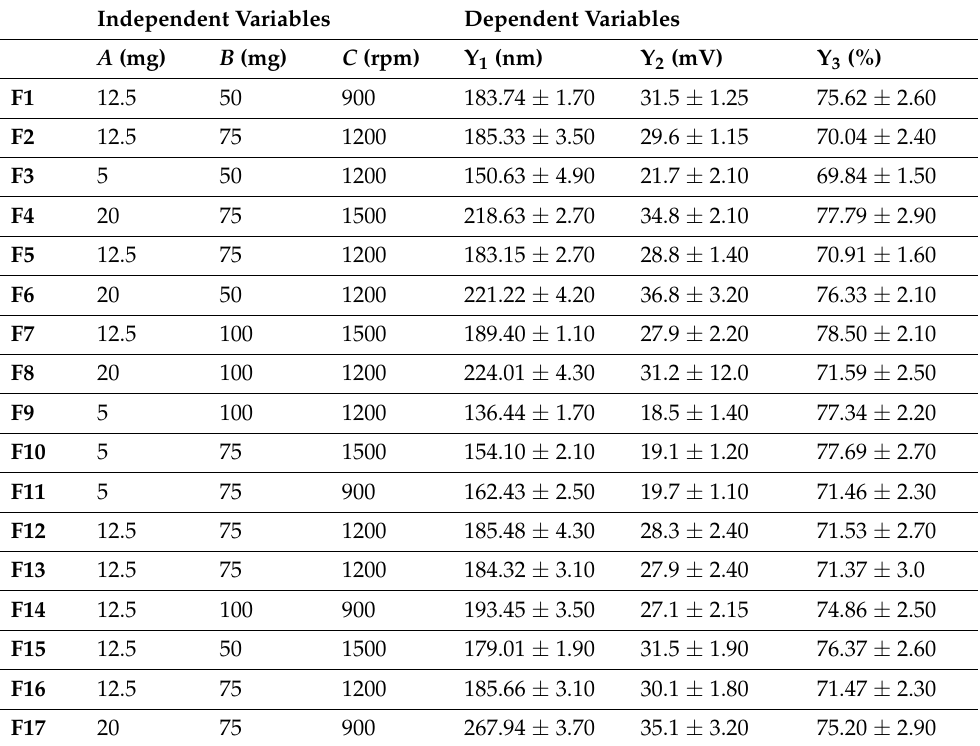
Table 2. CUR/LCSNPs experimental runs and observed responses for all of the seventeen formula- tions (F1–F17) exploiting the Box-Behnken statistical